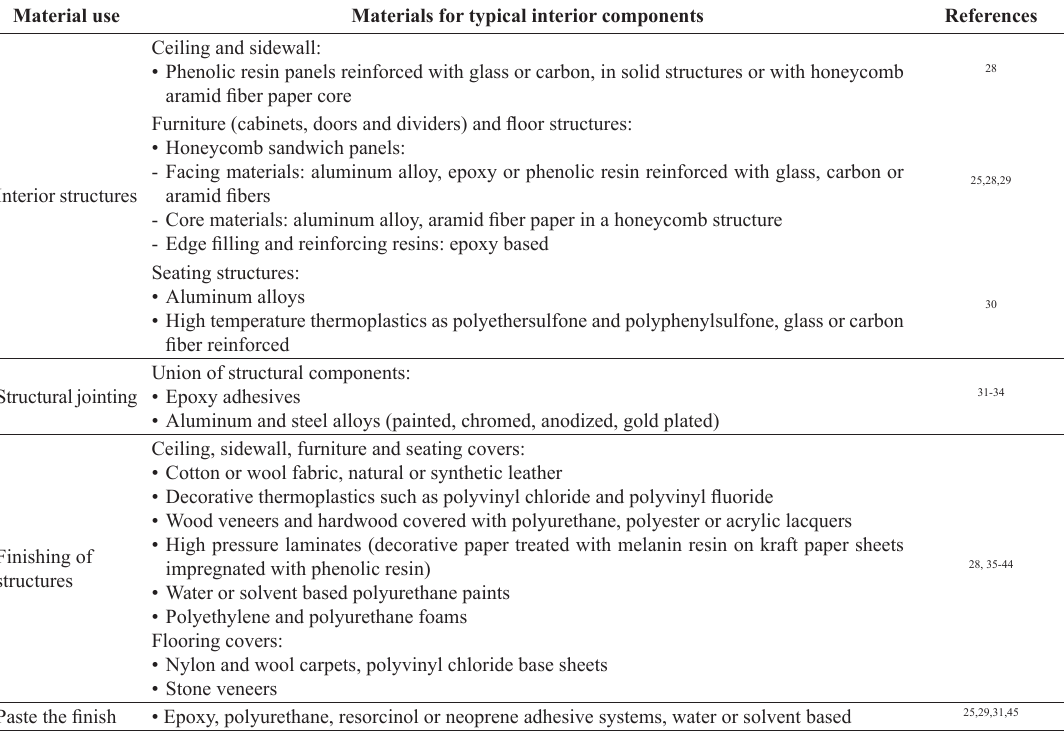
Table 2: The main materials currently used to produce aircraft interiors. Material